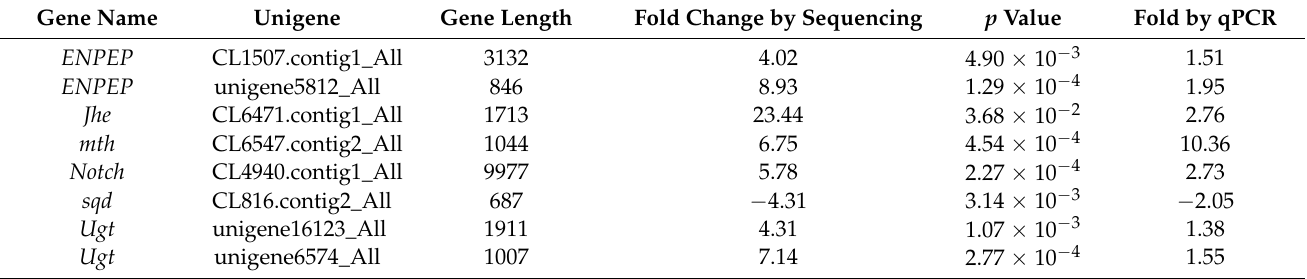
Table 4. Validation results of the selected differentially expressed